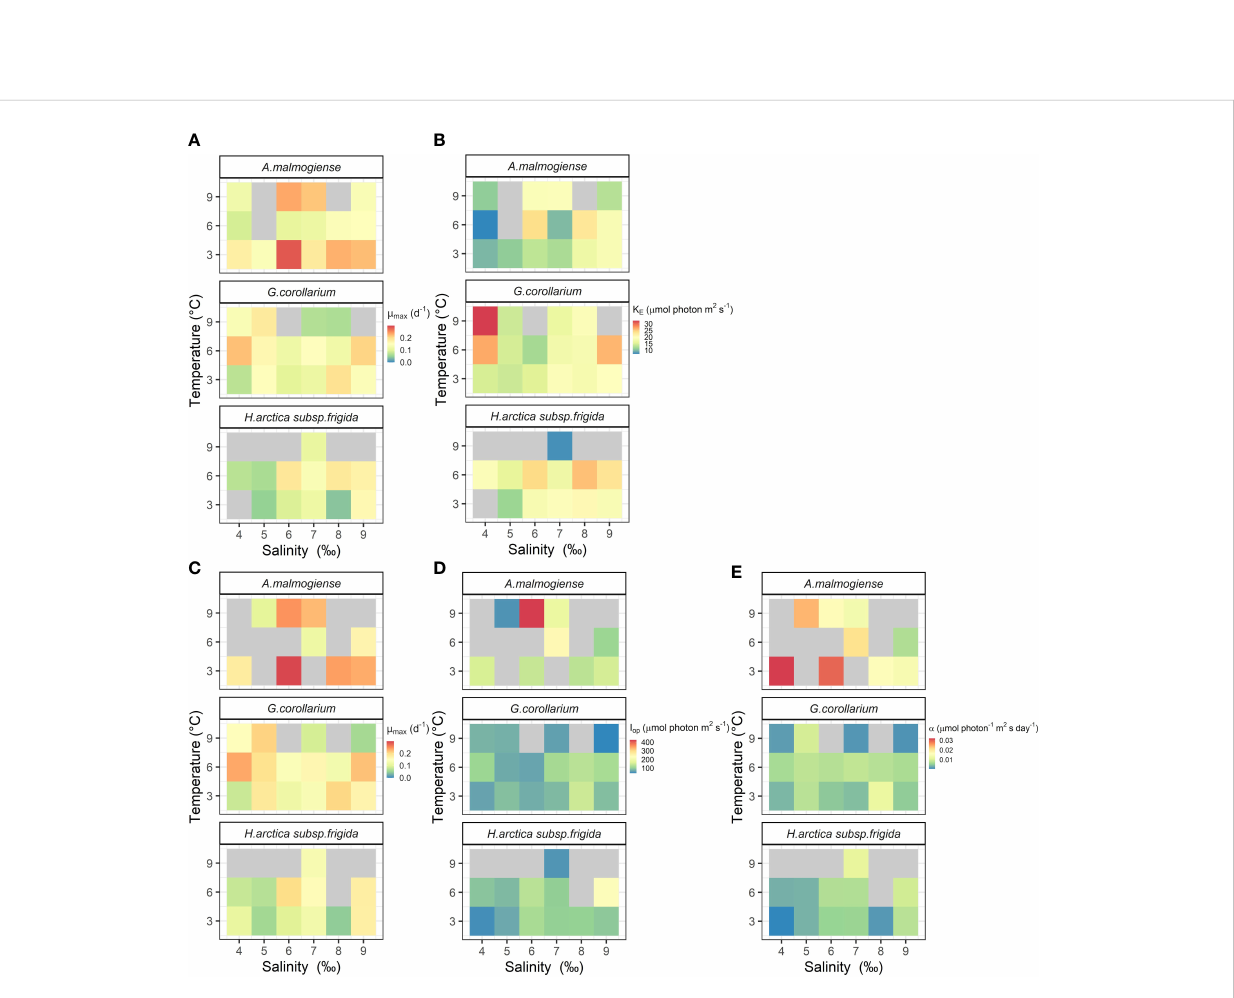
FIGURE 7 Photo-physiological traits estimated for Apocalathium malmogiense , Gymnodinium corollarium , and Heterocapsa arctica subsp. frigida at different temperatures and salinities. Parameters estimated using MacIntyre et al. (2002) two-parameter (A, B) or Eilers & Peeters (1988) three-parameter models (C – E) . Missing and non-signi fi cant parameters are depicted in gray.